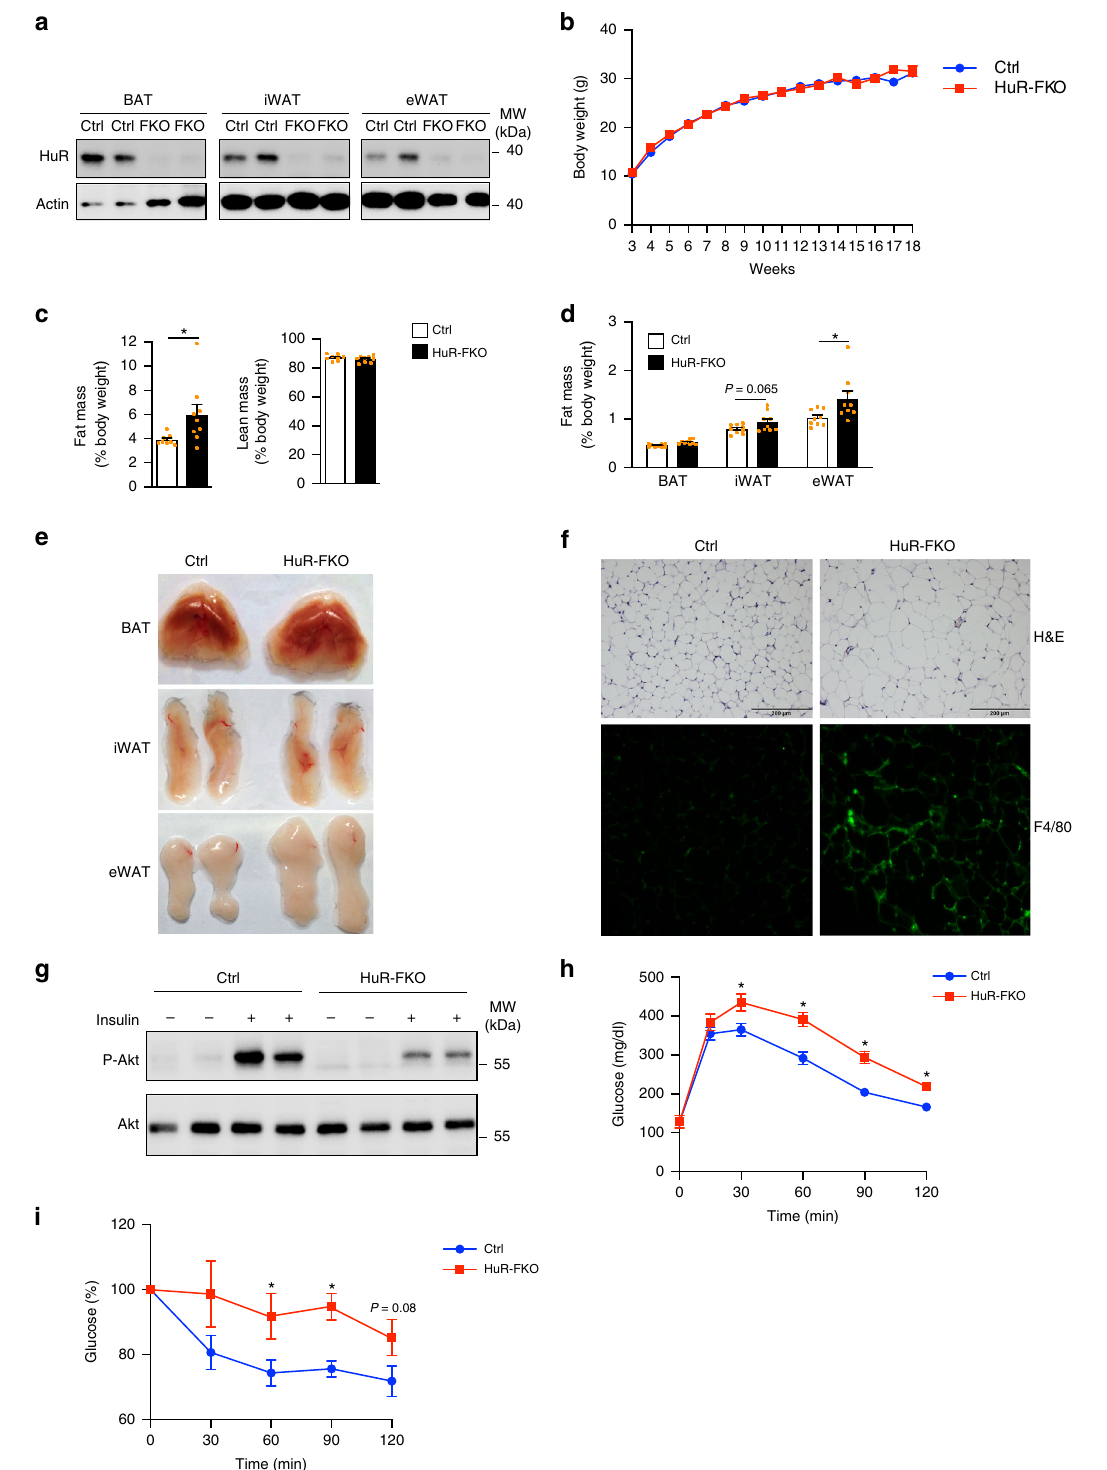
Fig. 2 HuR knockout in adipose tissue results in increased fat mass. a Western blot analysis of HuR expression in BAT, iWAT, and eWAT of HuR-KFO and control mice. b Body weight of male HuR-FKO and control ( HuR fl ox/ fl ox ) mice (Ctrl, n = 7; HuR-FKO, n = 10). c In vivo fat and lean mass by EcoMRI in 3-month-old male HuR-FKO and control littermates. (Ctrl, n = 8; HuR-FKO, n = 9). d The organ weights of BAT, iWAT, and eWAT in 3-month-old HuR- FKO and control littermates were normalized as a percentage of total body weight. n = 9 per group. e Representative picture of BAT, iWAT, and eWAT. f Morphological characteristics of eWAT by H&E staining and immunostaining of eWAT with F4/80. Scale bars represent 200 μ M. g Insulin-induced AKT phosphorylation in eWAT from HuR-FKO and Ctrl mice. Five minutes after IP insulin injection, mice were then sacri fi ced to harvest eWAT and examined its phosphorylation levels of AKT by western blot. h Blood glucose levels during glucose tolerance test (GTT) ( n = 9 per group) and i insulin tolerance test (ITT) of HuR-FKO and control littermates (Ctrl, n = 8; HuR-FKO, n = 6). Error bars are mean ± SEM. Statistical signi fi cance was determined by Student ’ s t -test; * p < 0.05. Source data are provided as a Source Data fi